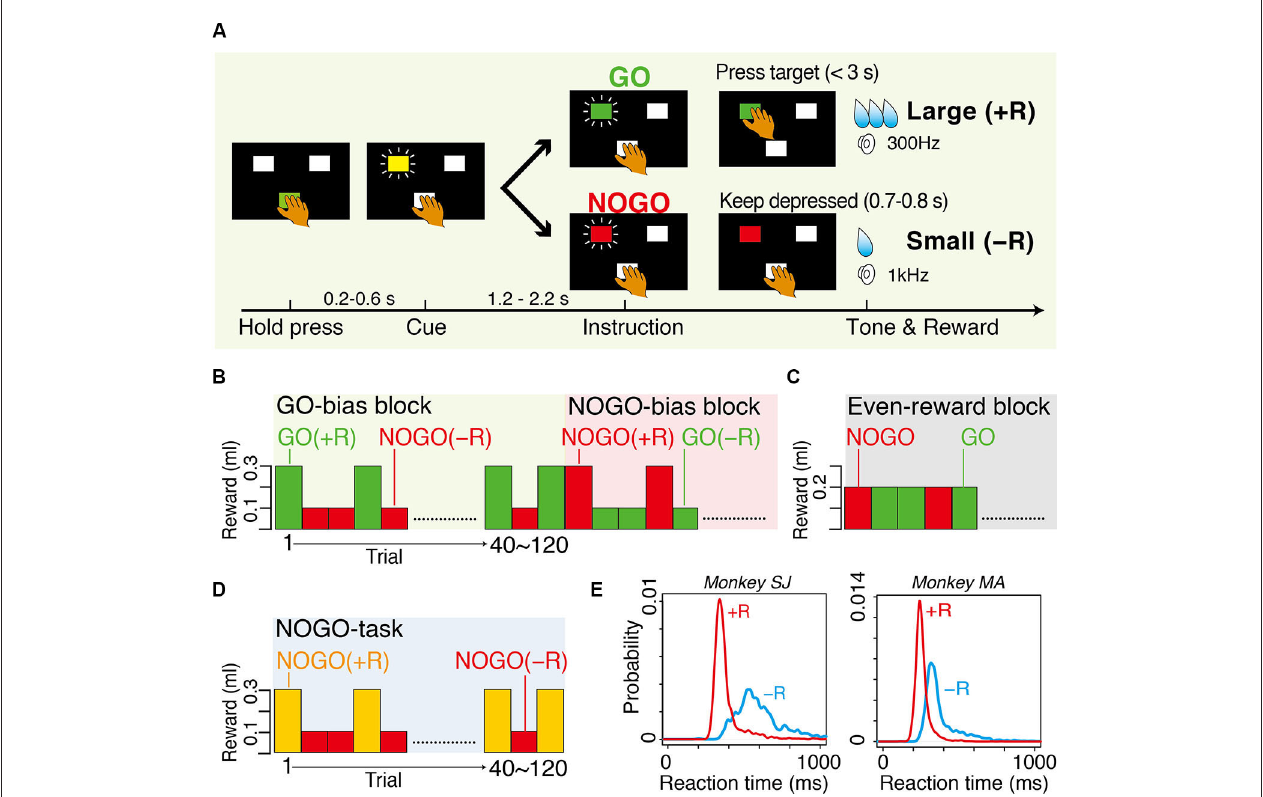
NOGO action was requested. Successful trials were rewarded with either large reward ( + R) or small reward ( − R), which was assigned by colored instruction (yellow or red). Timing of events was the same as that of GO-NOGO task. (E) Smoothed histograms of occurrence probability of reaction time. Red and blue curves are for GO( + R) and GO( − R) trials, respectively. Histograms have bin width of 1 ms and are smoothed with a Gaussian kernel (SD = 10